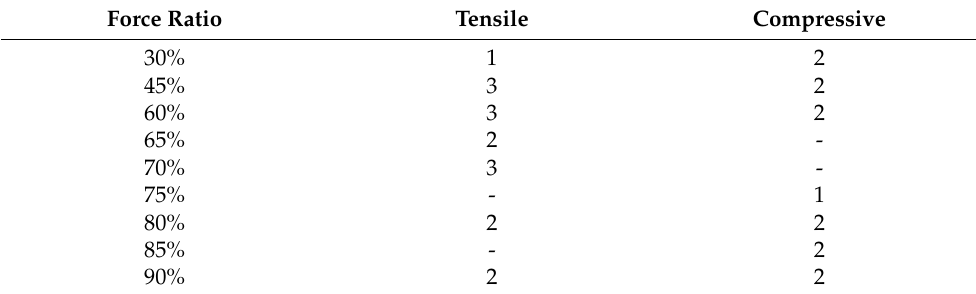
Table 1. Number of tensile samples tested at each force ratio.